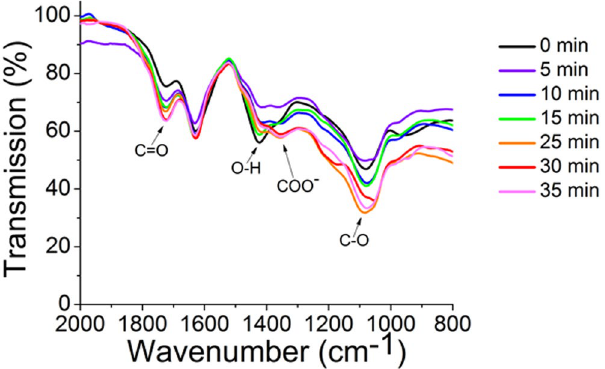
Figure 3. The IR spectra of ozone-treated GO. Observed transitions include C-O stretch (~1085 cm − 1 ), COO − stretch in COOH group (~1360 cm − 1 ), C-OH bend/-O-H deformation (~1425 cm − 1 ), and C = O stretch in COOH group (~1725 cm − 1